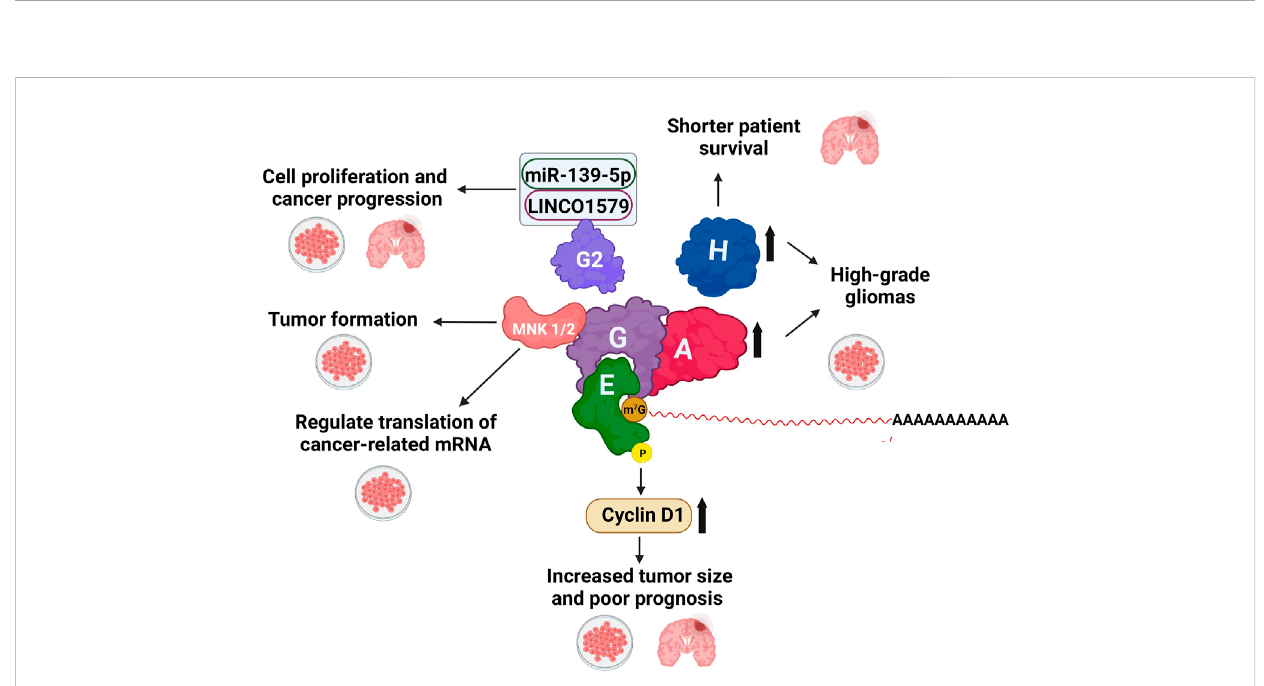
FIGURE 4 The eIF4F complex and the MNK1/2-eIF4E axis are involved in GB progression. eIFs are shown only with the respective numbers . Thick arrows indicate overexpression ( upward ) or downregulation ( downward ). Thin arrows indicate what GB process eIFs are involved in. The different phenomena observed in patients and in cultured cells, are indicated with a Petri dish and a brain ,